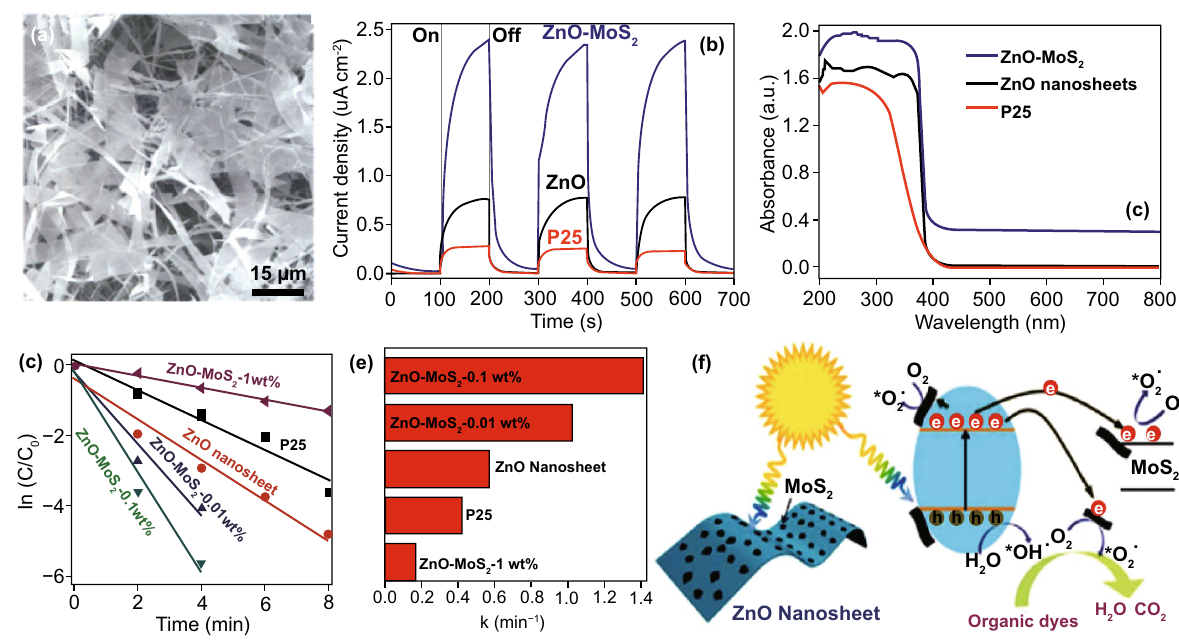
Fig. 27 a ln ( C / C 0 ) versus time curves of MB with different photo‑catalysts: ZnO/MoS 2 hetero‑structures with diverse doping amounts of MoS 2 (mass ratio is 0, 0.01, 0.1, and 1 wt%) and commercially available P25. b Obvious rate constants of MB photo‑degradation with different photo‑ catalysts. c Scheme showing photo‑catalytic system of ZnO/MoS 2 hetero‑structures. Adapted with permission from Ref.